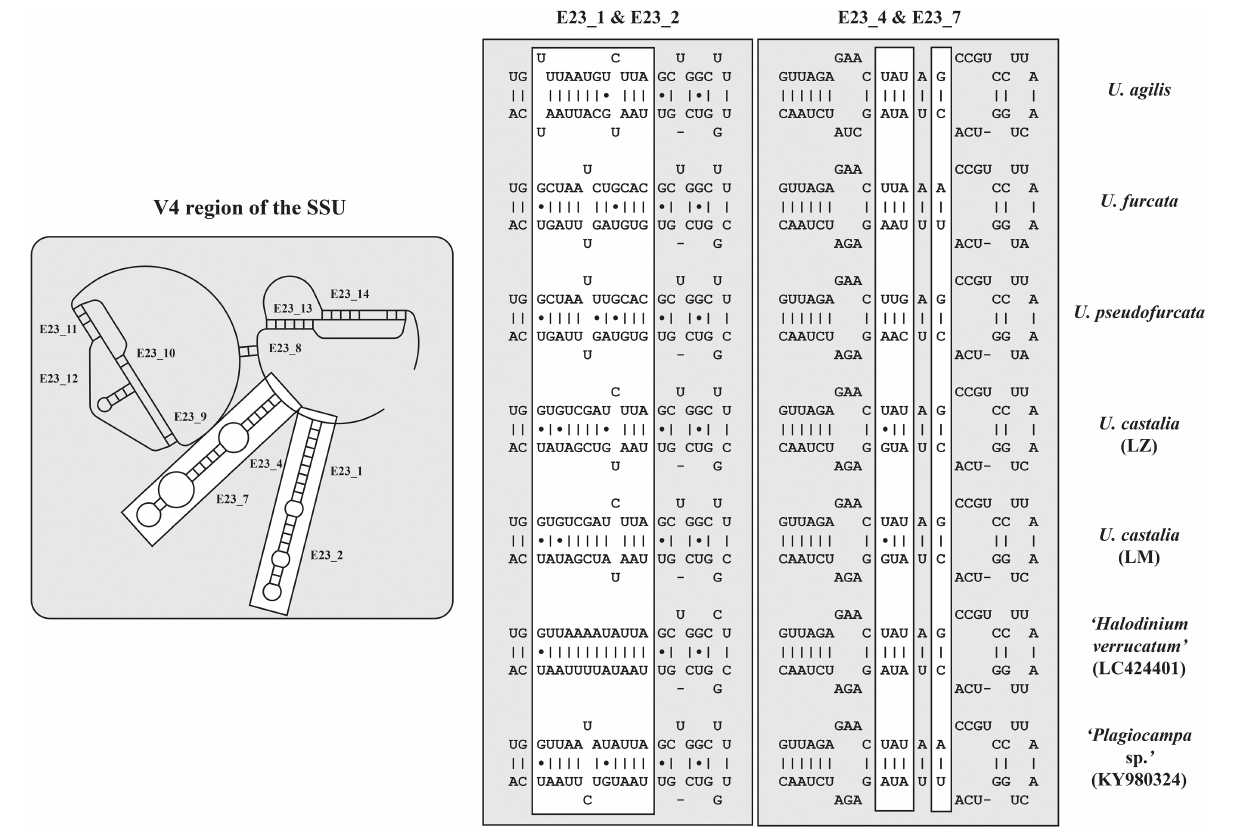
Frontiers in Microbiology |